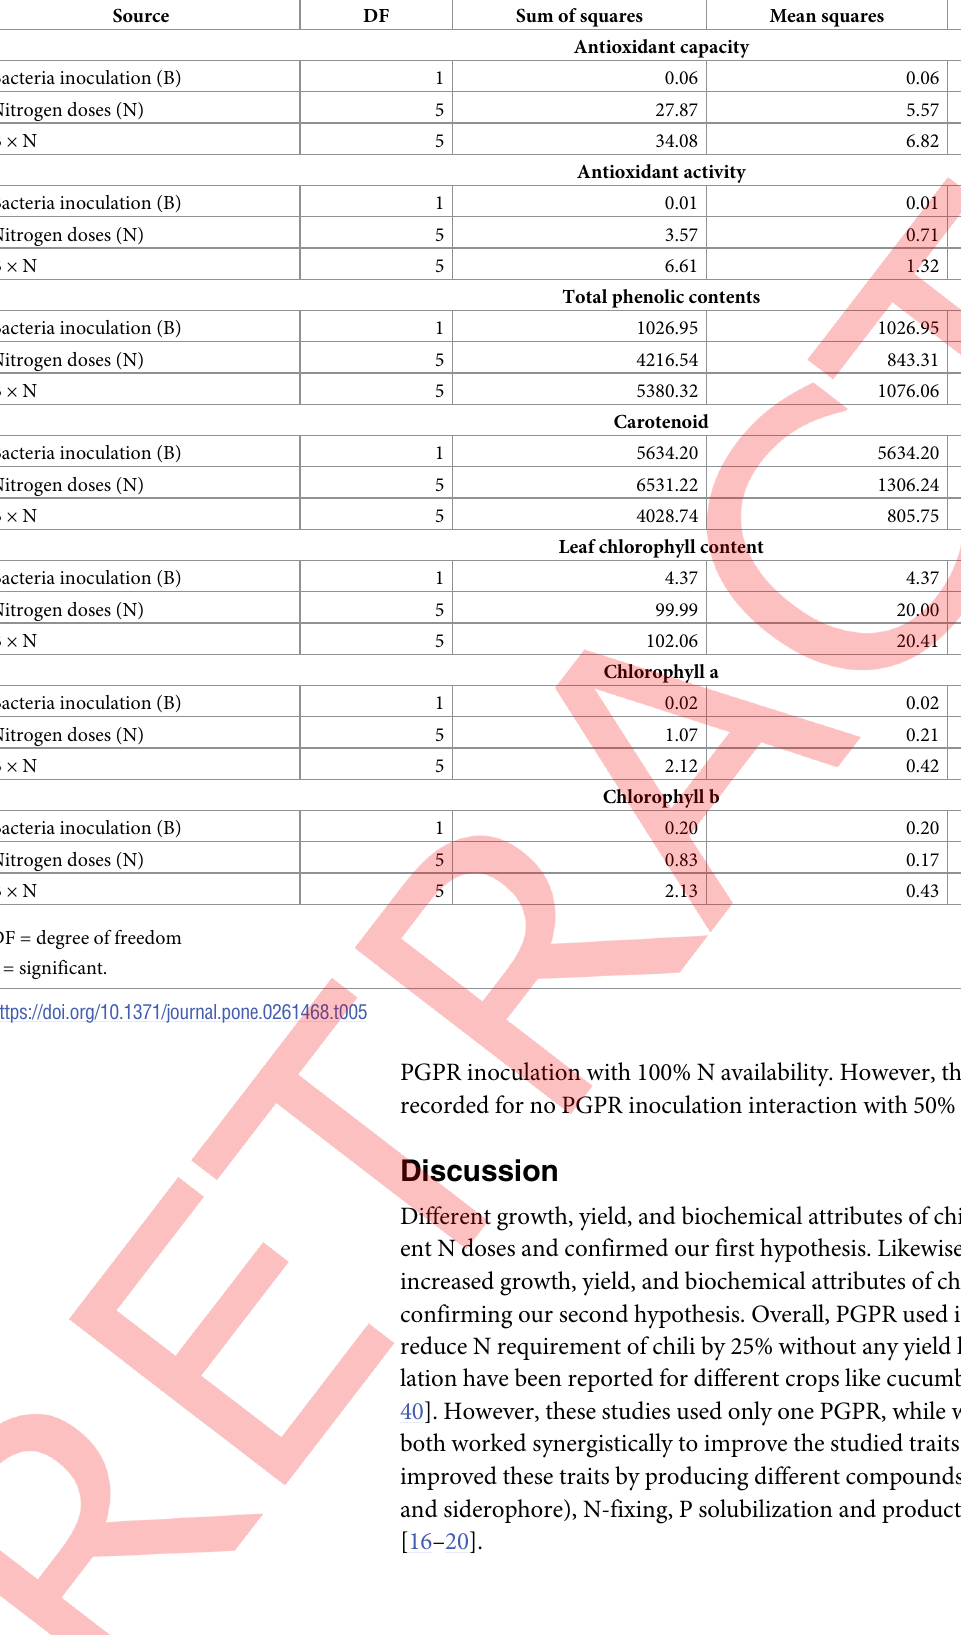
Table 5. Analysis of variance for biochemical traits of chili grown under different nitrogen doses and bacterial inoculation. Source DF Sum of squares